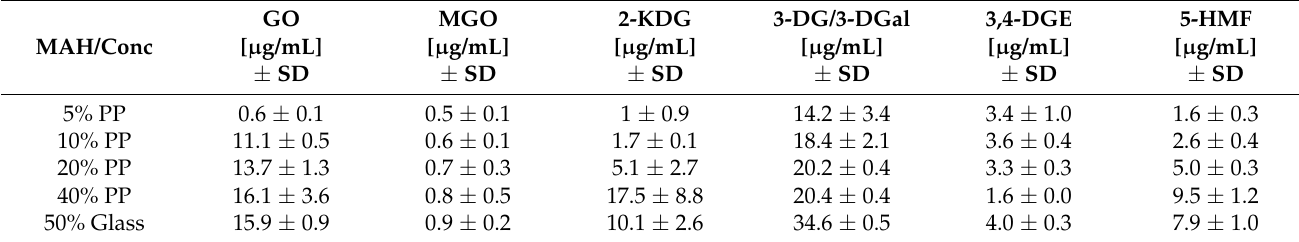
Table 8. Concentrations of GDPs. Manufacturer B ( n = 3).